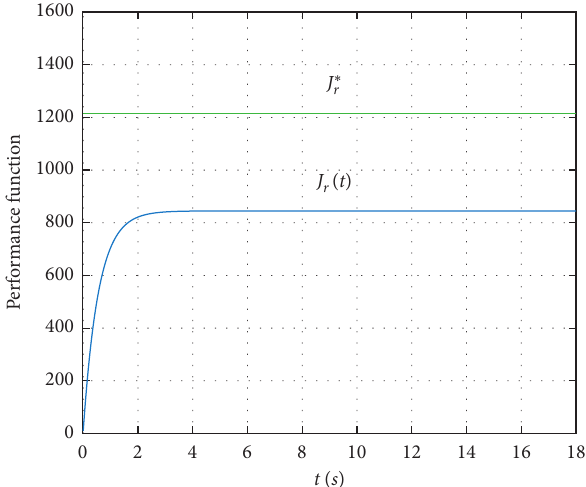
Figure 6: Performance function for dynamic whole motion.